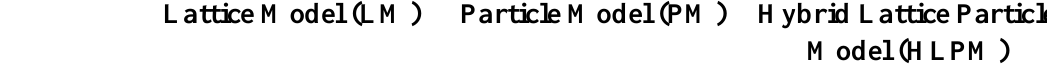
Table 1. Comparison of the lattice model (LM), the particle model (PM), and the hybrid lattice particle model (HLPM).